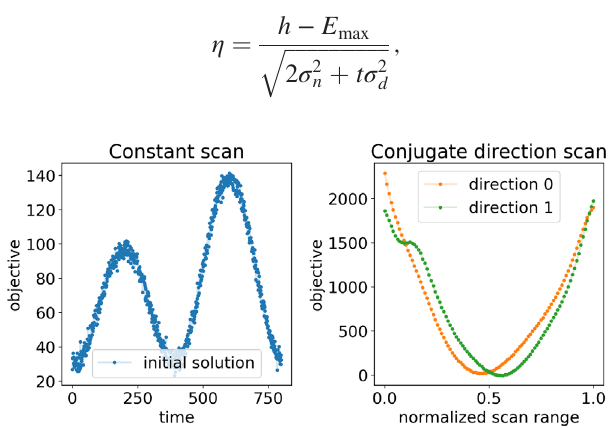
FIG. 7. Determination of the hyperparameters for 2D test problem. Left: variation of the objective function over time; right: objective function vs parameter scan in two directions. The initial solution is set to be the middle point in the 2D normalized decision space (0.5,0.5). The estimations of L and 0.8, respectively, derived from the scan